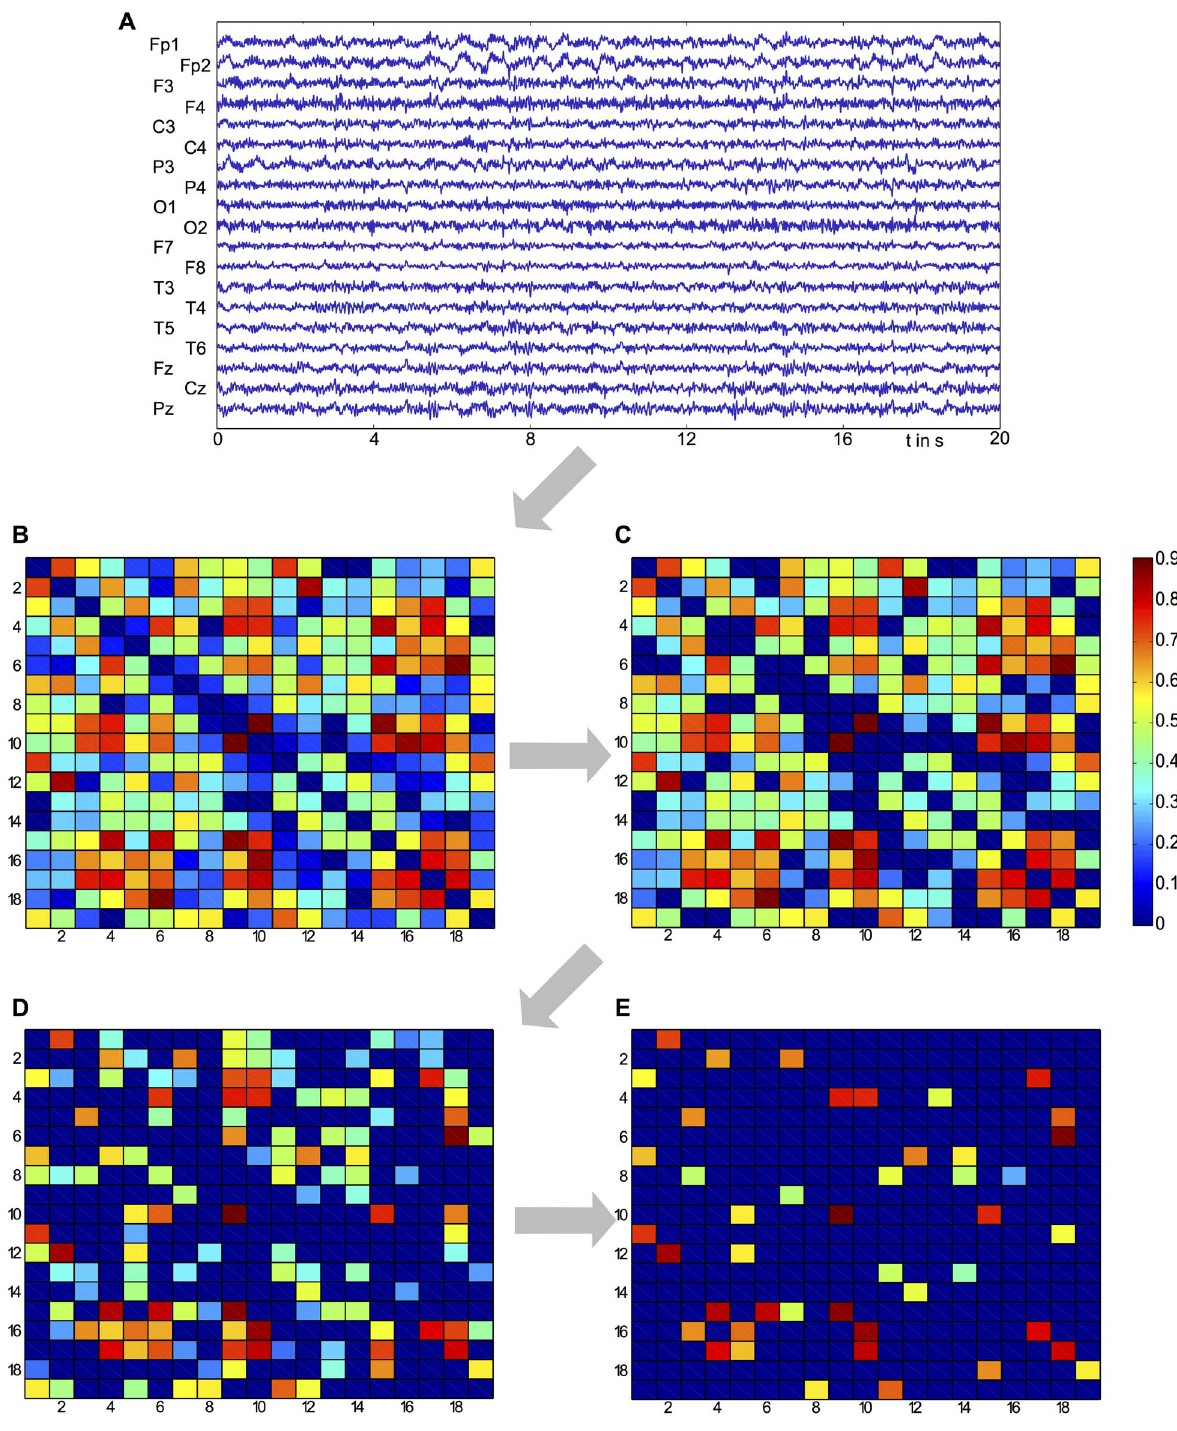
Figure 4. Illustration of the procedure to derive the functional network structure. A : An artefact-free 20s resting-state segment of EEG from each subject is extracted. B : Applying the time-lagged cross-correlation to all combinations of channel pairs yields a bidirectional connectivity matrix. C : Connections are removed if they are not significantly different from surrogate data ( 95 % level of significance). D : Using the time-lags, a unidirectional connectivity matrix can be inferred. E : Setting to zero all connections that can be explained by stronger, indirect connections removes spurious connections.